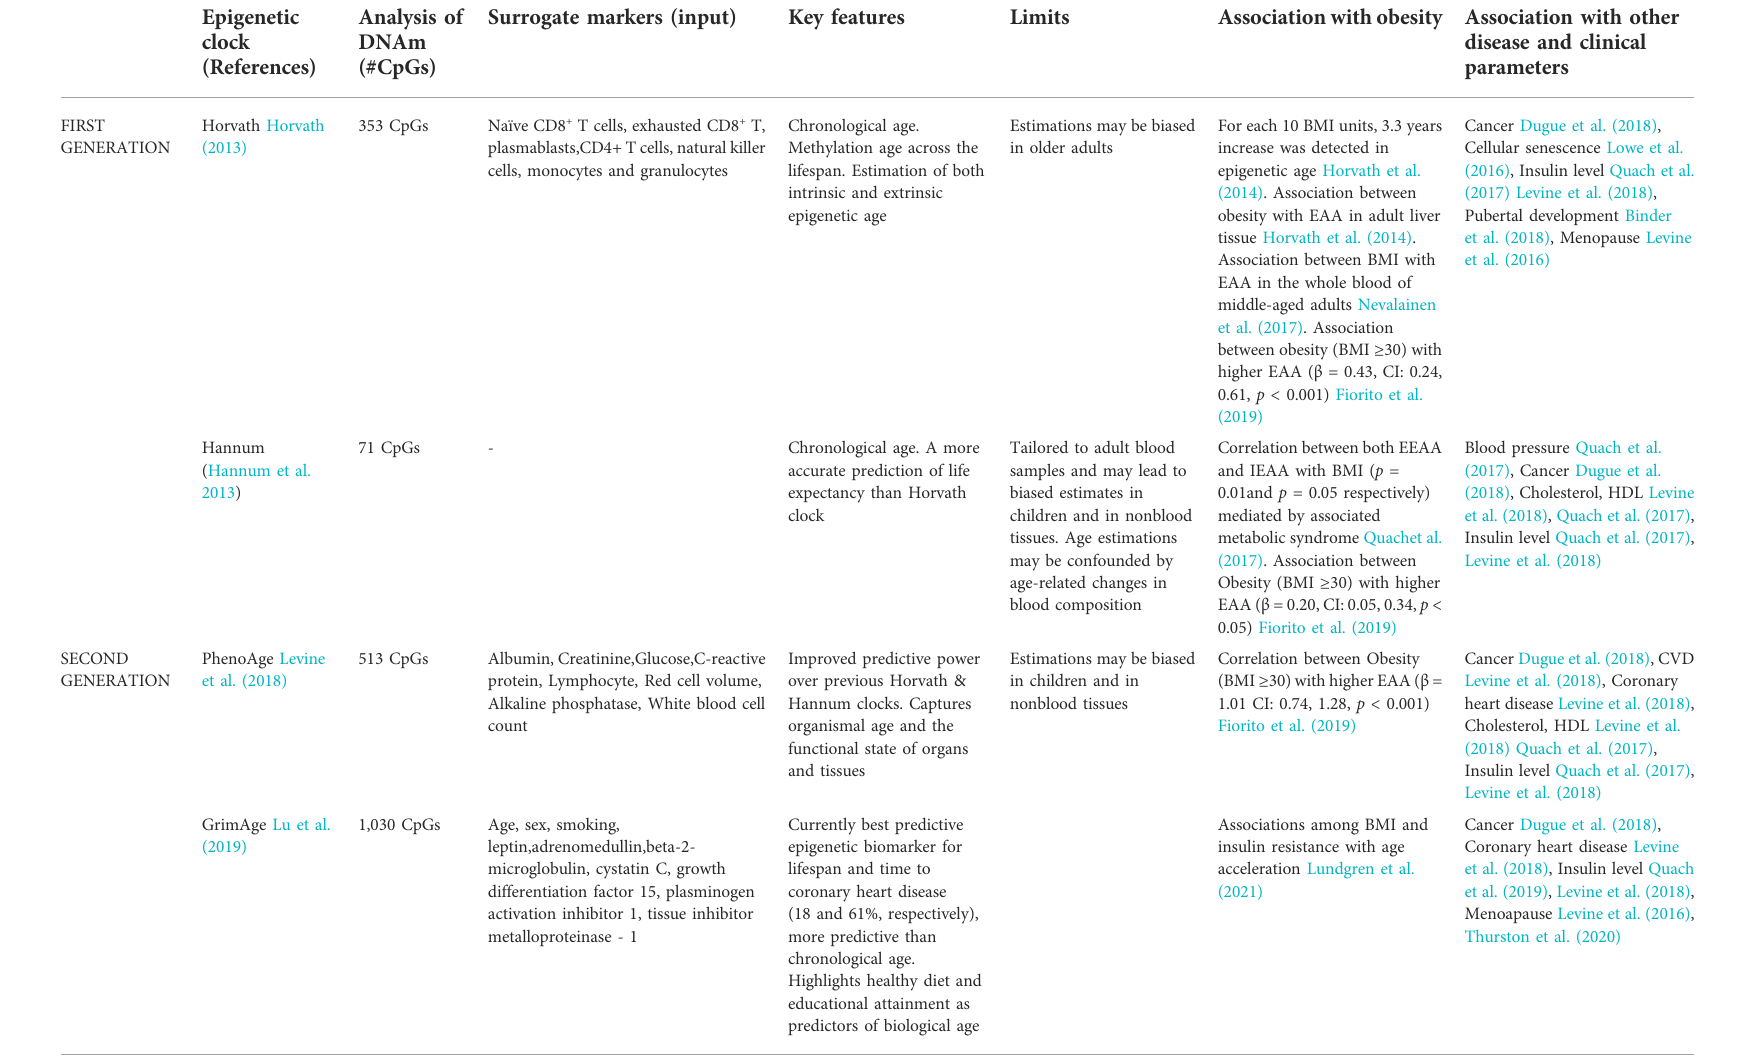
TABLE 1 Summary of fi rst-generation (Hannum and Horvath), second (DNAm PhenoAge, GrimAge) and third-generation (DunedinPoAm) epigenetic